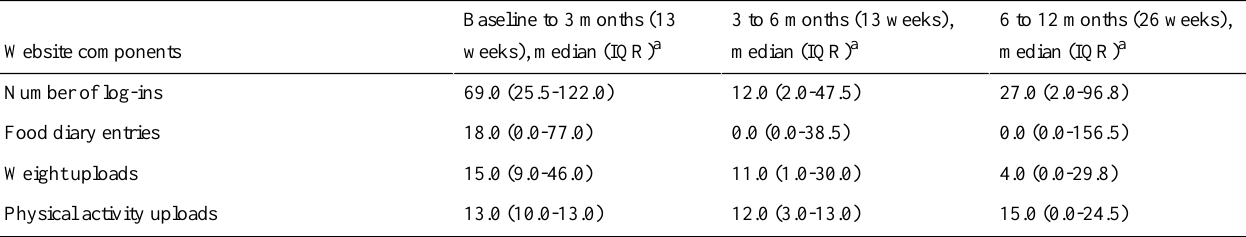
Table 5. Website utilization patterns (intervention group only) from baseline to 3, 6, and 12 months.